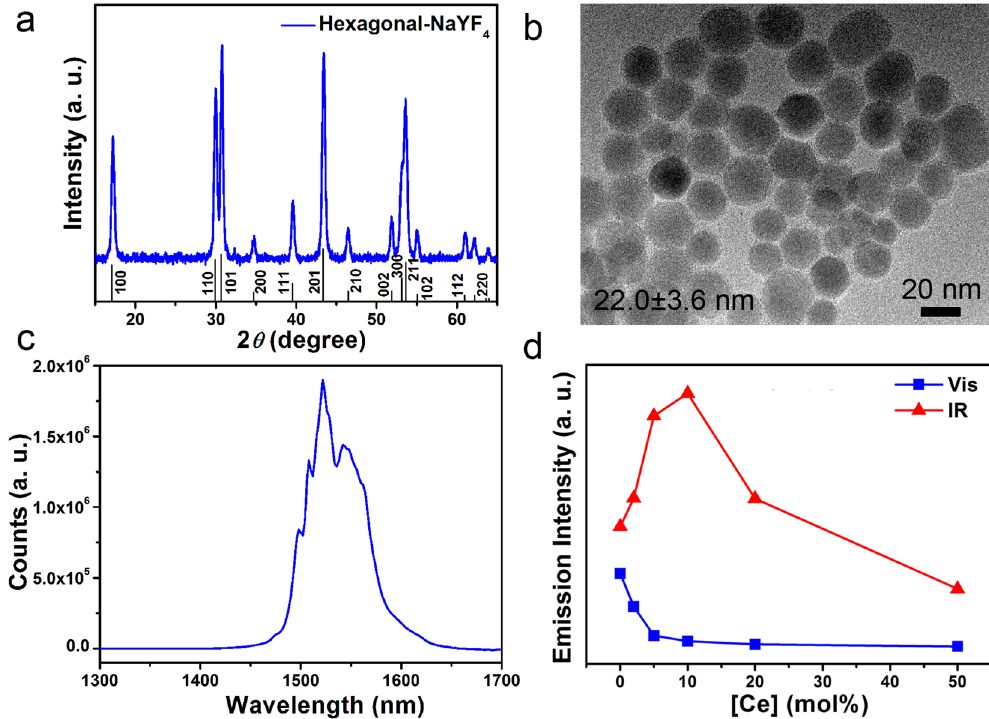
Figure 1. Characterization of our brightly IR-emitting NaYF 4 :Yb 20 Er 2 Ce 10 core-shell nanoparticles (N-NPs). ( a ) XRD pattern showing hexagonal structure; ( b ) TEM image showing the N-NP size distribution; ( c ) Steady- state IR emission spectrum showing characteristic peak emission at 1530 nm corresponding to the 4 I 13/2 → 4 I 15/2 Er transition; ( d ) Integrated IR emission intensity at different Ce concentrations for 20 mol% Yb and 2 mol% Er, where the optimum was at ~10 mol% of